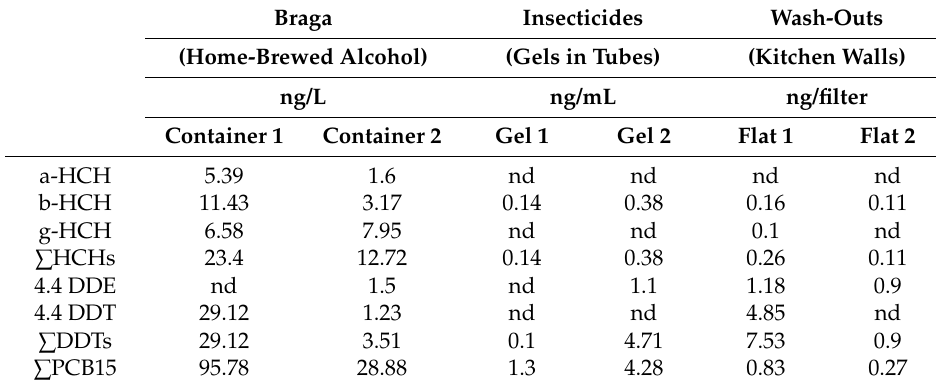
Table 5. Concentrations of HCHs, DDTs and PCBs in samples of home-brewed alcohol, insecticides and wash-outs of kitchen walls in Enmelen settlement. Braga Insecticides Wash-Outs (Home-Brewed Alcohol) (Gels in Tubes) (Kitchen Walls) ng/L ng/mL ng/filter Flat